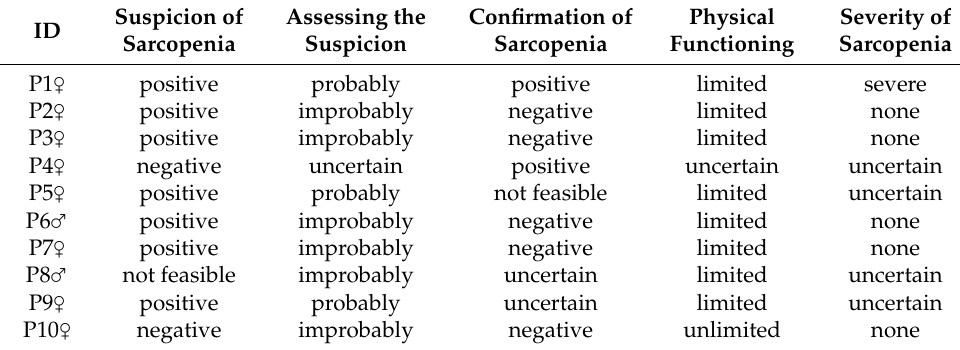
Table 6. Quantification of sarcopenia by individual